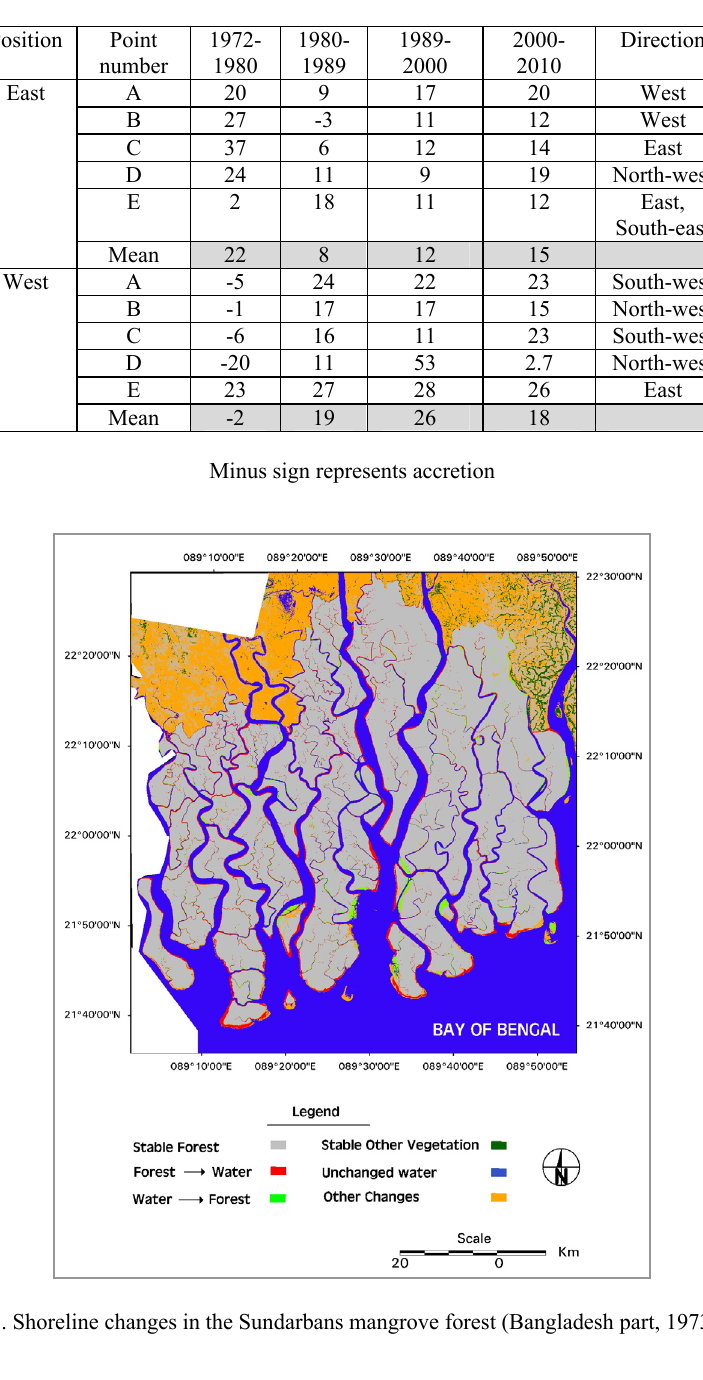
Table 4. Time-series analysis of mean erosion rate (m/year) at different point